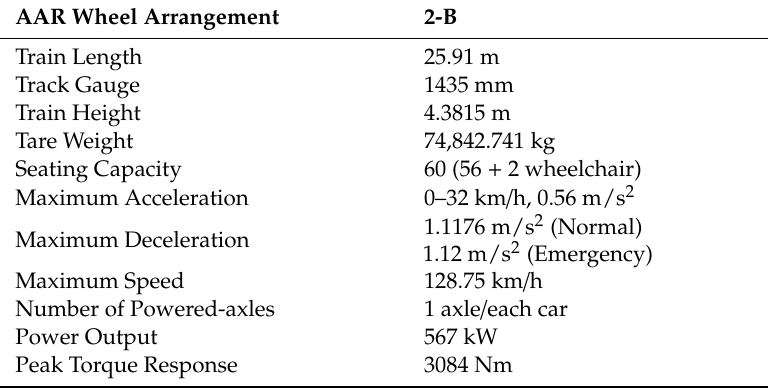
Table 1. Self-Propelled Diesel Multiple Unit (DMU) Train Specification